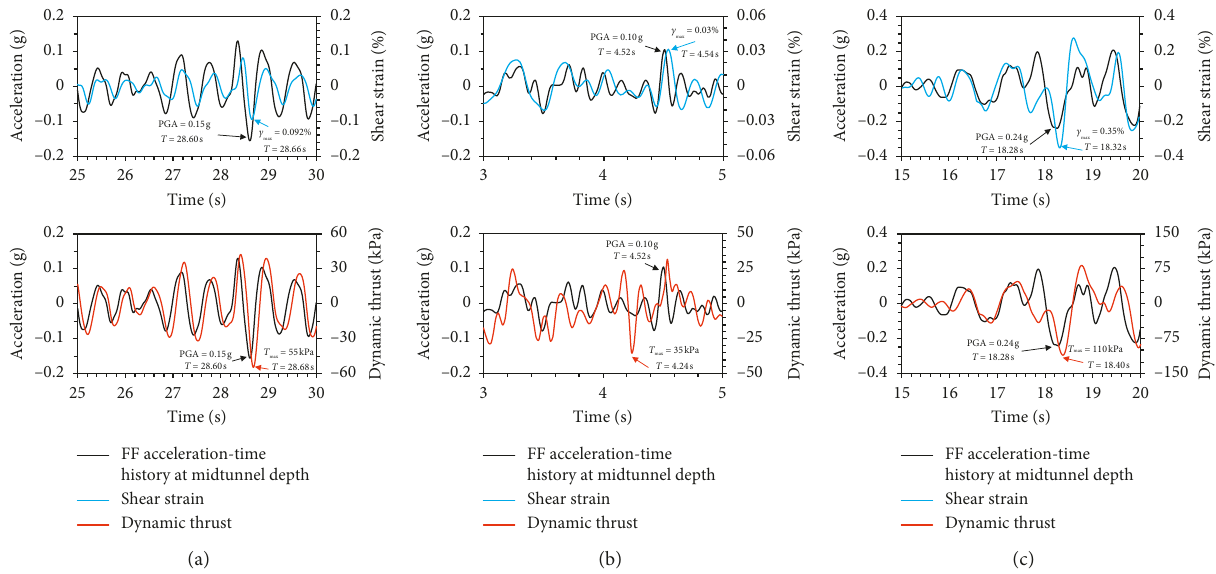
Figure 15: Comparison of free-field acceleration at tunnel middepth, shear strain, and dynamic increment of thrust in stiff soil-tunnel configuration for (a) Loma Prieta, (b) Nahanni, and (c) Chi-Chi